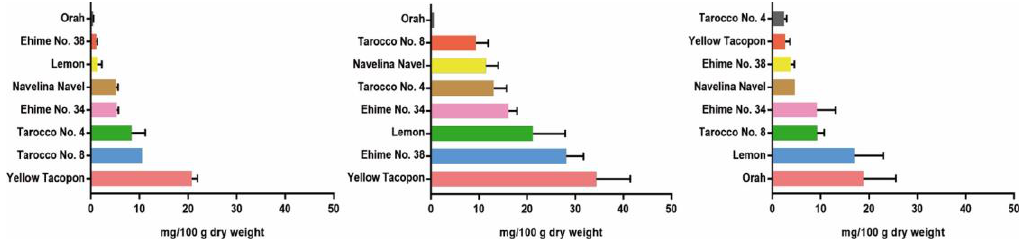
Figure 3. Nomilin content of citrus varieties at different fruit growth stages (mean ± SD). Left: falling stage; middle: young fruit stage; right: mature stage.